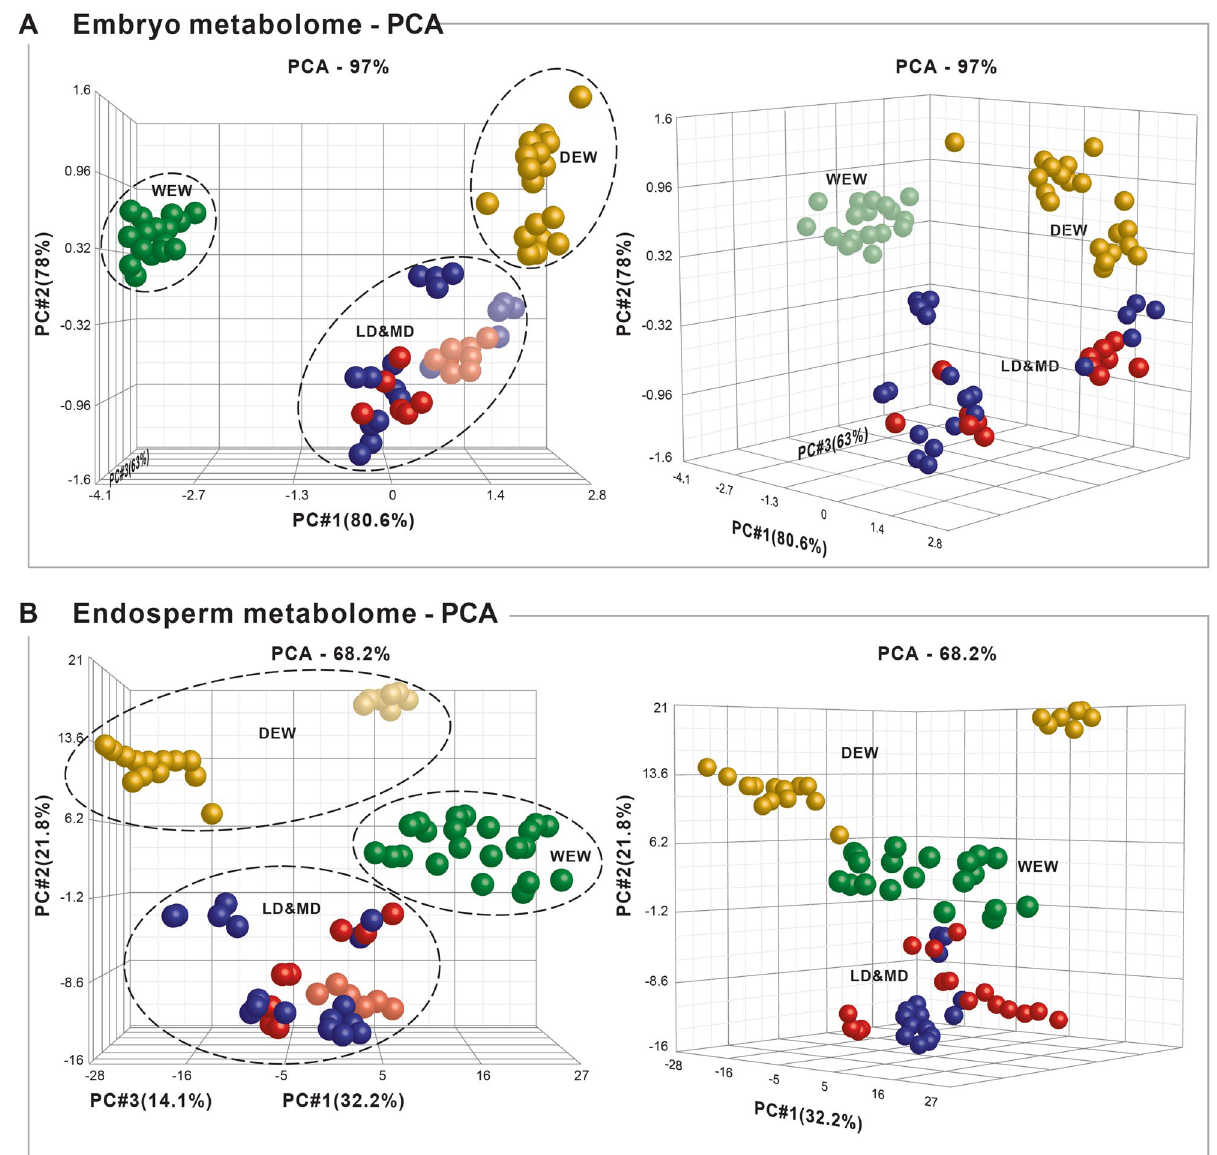
Figure 3. Three-dimensional models of principal component analyses (PCA) of the 19 wheat accessions, representing three wild and domesticated tetraploid wheat subspecies at various stages of domestication: wild emmer wheat (WEW; T. turgidum ssp . dicoccoides ), domesticated emmer wheat (DEW; T. turgidum ssp . dicoccum ), durum landraces (LD; T. turgidum ssp . durum ), and modern durum (MD; T. turgidum ssp . durum ; see Table 1 for details of each accession). Each sphere represents the quantile-normalized metabolome of one replicate accession; well-separated groups are indicated with dashed lines. ( A ) Two views of the PCA of the embryo metabolomes. ( B ) Two views of the PCA of the endosperm